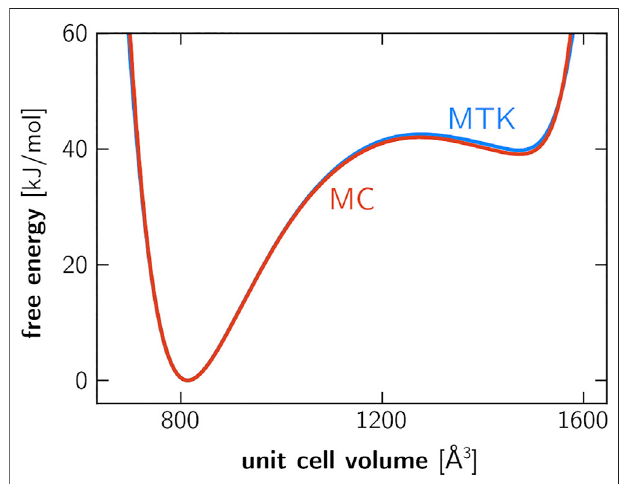
FIGURE 2 | Helmholtz free energy of a 1 × 2 × 1 unit cell of MIL-53(Al), computed using umbrella sampling ( Supplementary Section S3 ). The blue curve is obtained based on simulations that were performed using the MTK barostat, whereas the red curve was obtained using the proposed Monte Carlo barostat. The discrepancy in relative stability between the lp and cp phases isaround 0.9 kJ/mol. While simulations were performed on the 1 × 2 × 1 cell, the unit cell volume axis employed here refers to the 1 × 1 × 1